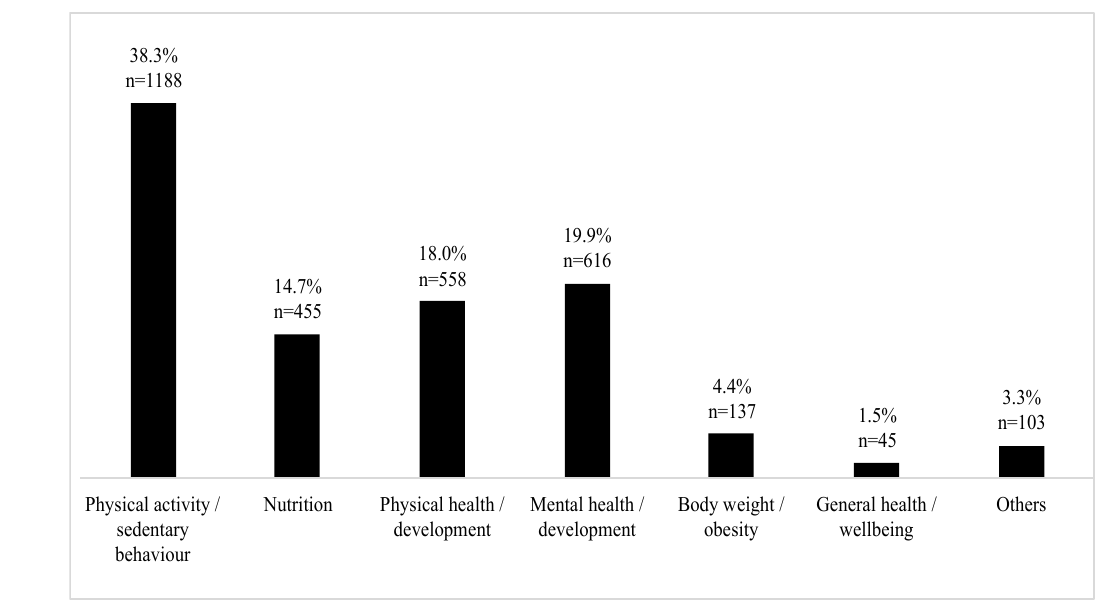
Figure 3. Frequency of health indicators examined in the scoping review (%, n ). Figure 4 presents the associations between early ECEC centers MLCs and the health, health behavior, and wellbeing of the children.